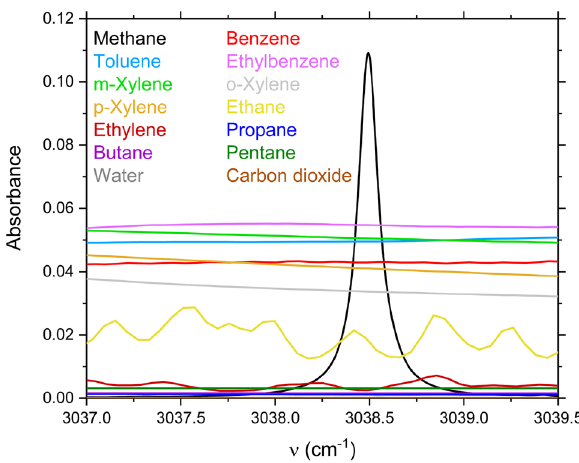
Figure 1. Absorbance spectra for methane, benzene, toluene, ethylbenzene, m-xylene, o-xylene, p-xylene, ethane, ethylene, propane, butane, pentane, water vapor, and carbon dioxide over 3037–3039.5 cm -1 at T = 298 K, P = 1 atm, L = 10 cm 51,52 .